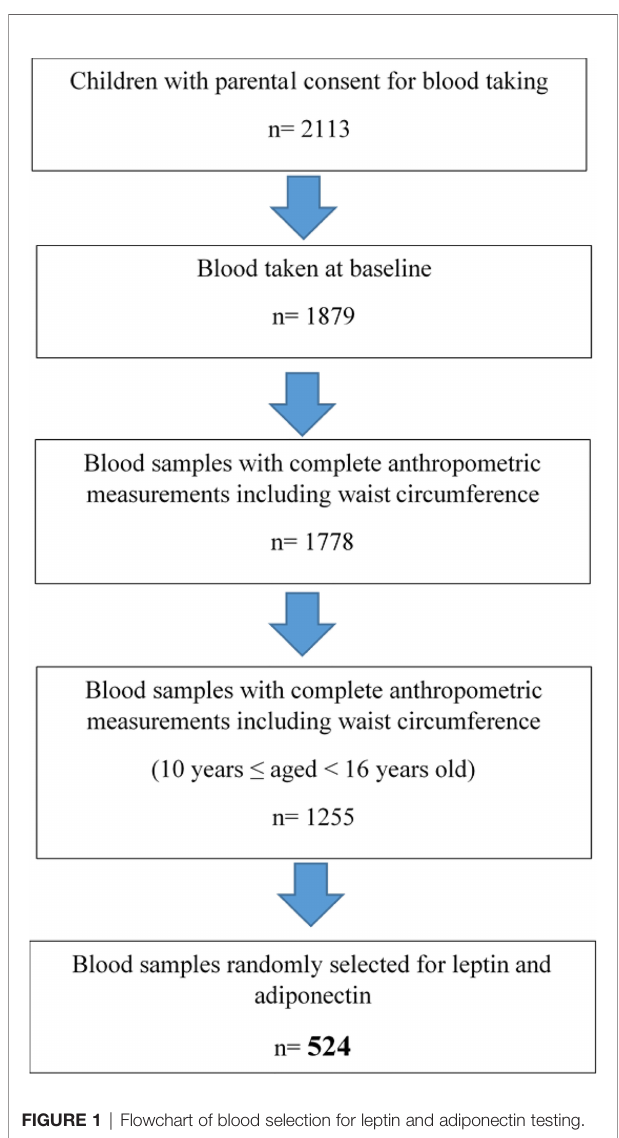
FIGURE 1 | Flowchart of blood selection for leptin and adiponectin